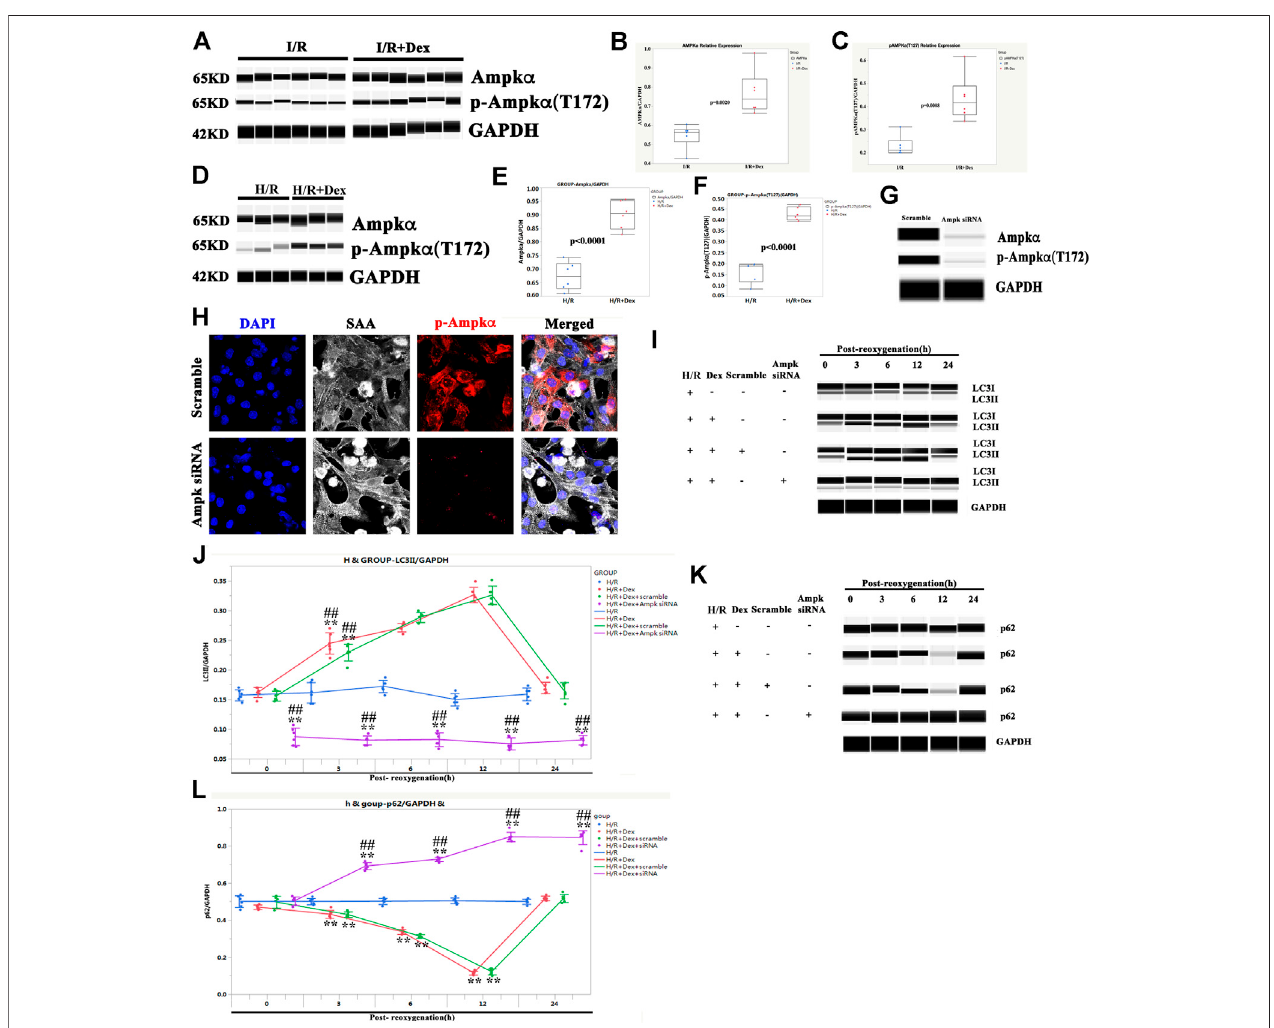
FIGURE 6 | The autophagy induced by Dex was AMPK dependent. (A) Representative AMPK/p-AMPK Wes blot of a human ventricle pretreated with Dex. (B) Quanti fi cationoftheAMPKrelativeexpression ofahumanatria.N (cid:2) 6patients. (C) Quanti fi cationofthep-AMPK relative expressionofahumanventricle.N (cid:2) 6patients. (D) Representative AMPK/p-AMPK Wes blot of iPSC-CMs pretreated with Dex. (E) Quanti fi cation of the AMPK relative expression of iPSC-CMs. N (cid:2) 6 replicates. (F) Quanti fi cation of the p-AMPK relative expression of iPSC-CMs. N (cid:2) 6 replicates. (G) The expression of AMPK and p-AMPK were reduced by AMPK siRNA, as indicated by the Wes blot. (H) The expression of p-AMPK was reduced by AMPK siRNA, as indicated by immunostaining. (I) AMPK siRNA blocked the increased expression ofLC3II by Dex, as indicated by the Wes blot. (J) Quanti fi cation of the LC3II expression in Panel 6I. (K) AMPK siRNA blocked the reduced expression of p62 by Dex, as indicated by the Wes blot. (L) Quanti fi cation of the p62 expression in Panel 6K. ** p < 0.01. vs. H/R; ## p < 0.01, vs. H/R +